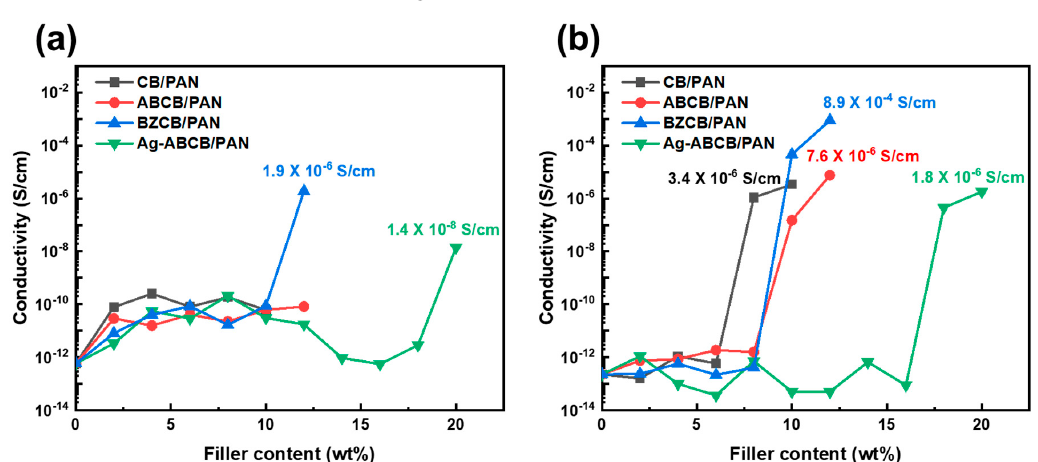
Figure 4. TGA thermograms of modified CBs in ( a ) air and ( b ) N 2 .